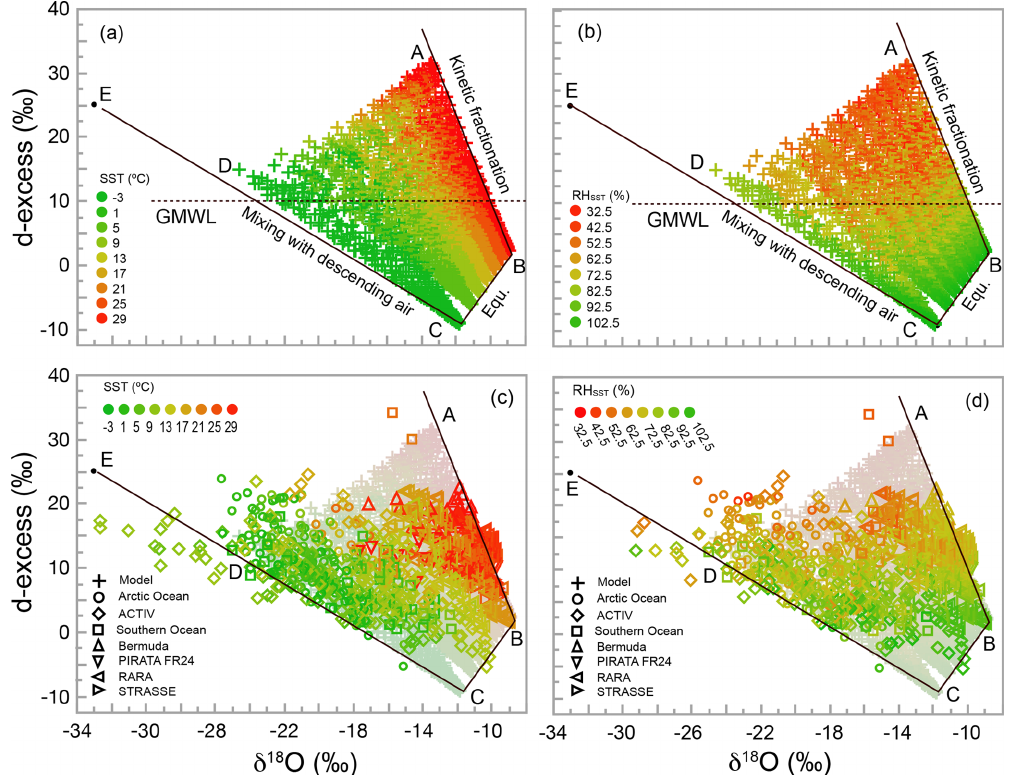
Figure 6. Plots of d-excess vs. δ 18 O, showing the relationship between d-excess and SST for the simulation (a) and model–data compari- son (c) and between d-excess and RH SST for simulation (b) and model–data comparison (d) . As in Fig. 4, isotopic values are calculated at a height of 15m. Points corresponding to those from A to E in Fig. 4 are also shown, with point E being the isotopic composition of the descending air. Straight lines are theoretical limits for processes labeled in (a) and (b) (also discussed in Sect. 6.1.2). The horizontal dashed lines in (a) and (b) mark the d-excess value (10) of the global meteoric water line